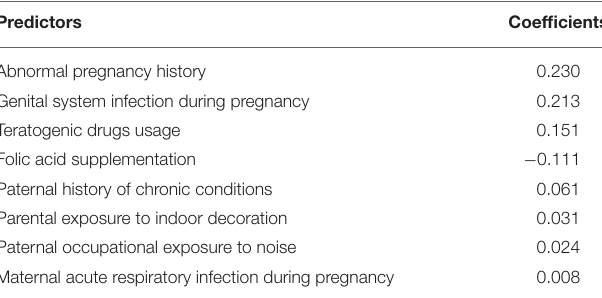
TABLE 2 | Predictors selected by lasso